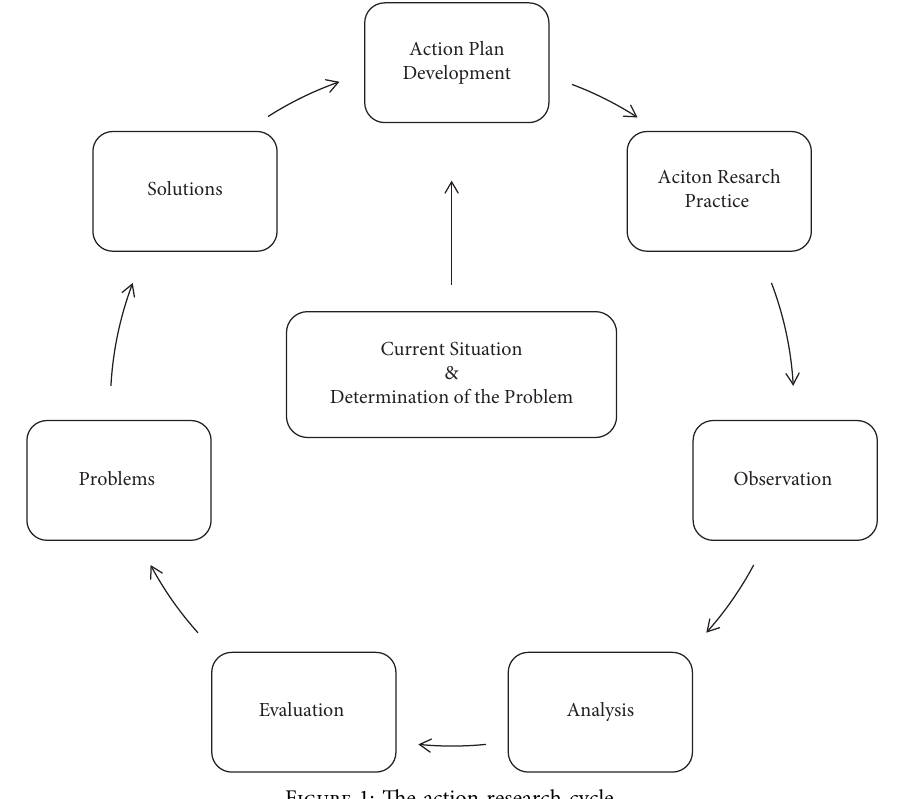
Figure 1: The action research cycle.